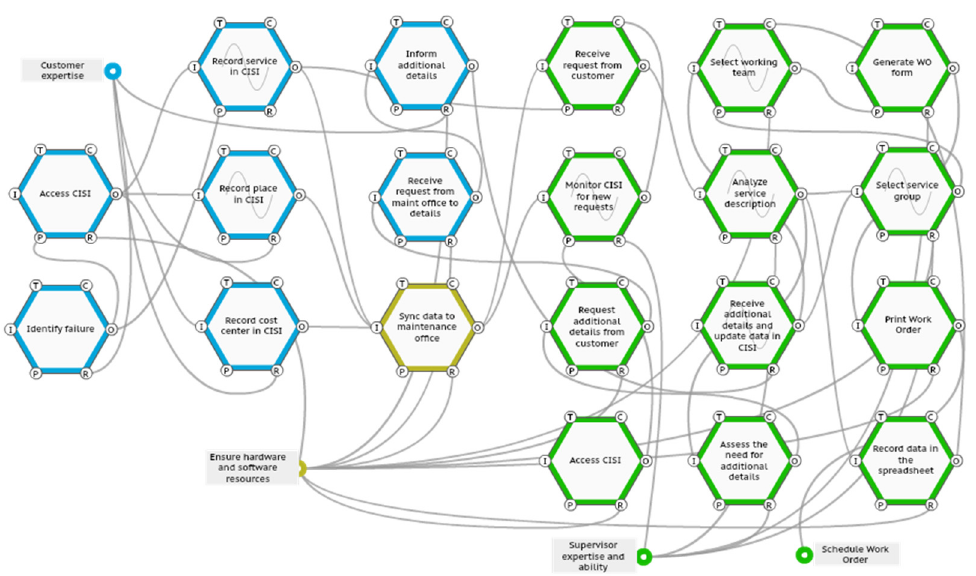
Figure 5. FRAM model of WOs issuance as performed for the maintenance of heating, ventilation, and air conditioning (HVAC) systems in the research & development (R&D) organization. Table 1. Potential variability identified in the work order issuance for the maintenance in HVAC systems . Nº